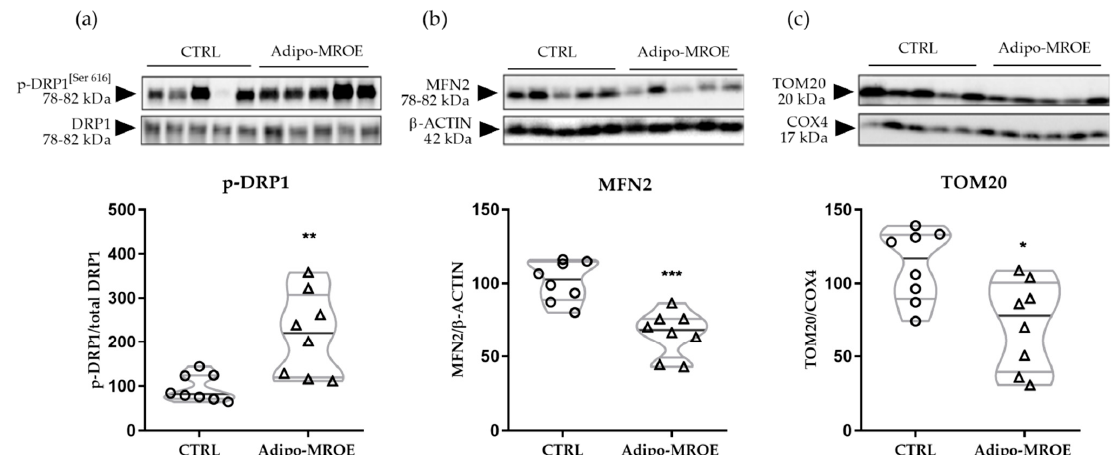
Figure 5. Mitochondrial dynamics are shifted towards fission and mitochondrial degradation, through mitophagy, is impaired in the EVAT of adipocyte-MR overexpressing mice. ( a ) DRP1 phosphorylation and ( b ) MFN2 protein levels, as measured by Western blot, are decreased in the EVAT of Adipo-MROE mice, indicating a shift of dynamics towards fission. ( c ) Protein levels of TOM20 are decreased in the EVAT of Adipo-MROE mice, indicating increased degradation through mitophagy. TOM20 protein levels are normalised by COX4 (mitochondrial protein) to exclude the variation linked to mitochondrial mass. Data are expressed as violin plots with quartiles and individual dots. n = 8 mice per group; * p < 0.05; ** p < 0.01; *** p < 0.001, Adipo-MROE vs. control. COX4: cytochrome c oxidase subunit 4; DRP1: dynamin-related protein 1; MFN2: mitofusin-2; MR: mineralocorticoid receptor; TOM20: translocase of outer membrane subunit 20.